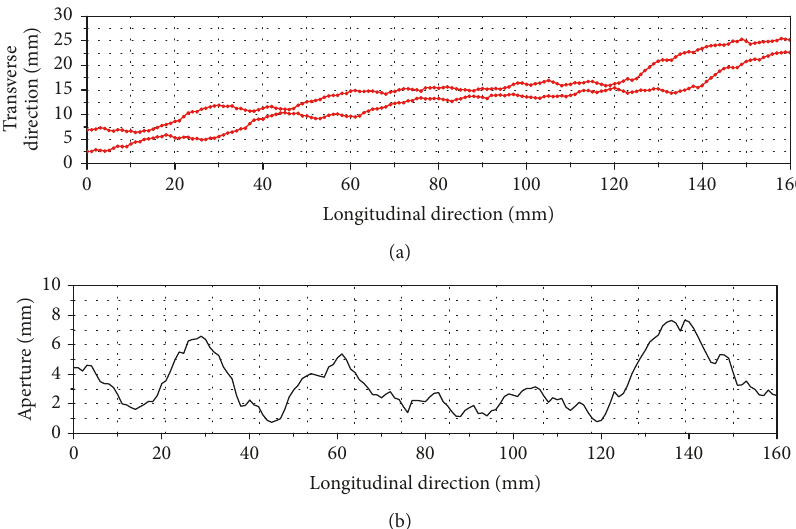
Figure1:Generatedsingleself-affinefracturewithH=0.8byusingthesuccessiverandomadditionstechnique.(a)Illustrationofthegenerated self-affine fracture walls. (b) Local aperture as a function of longitudinal distance along the